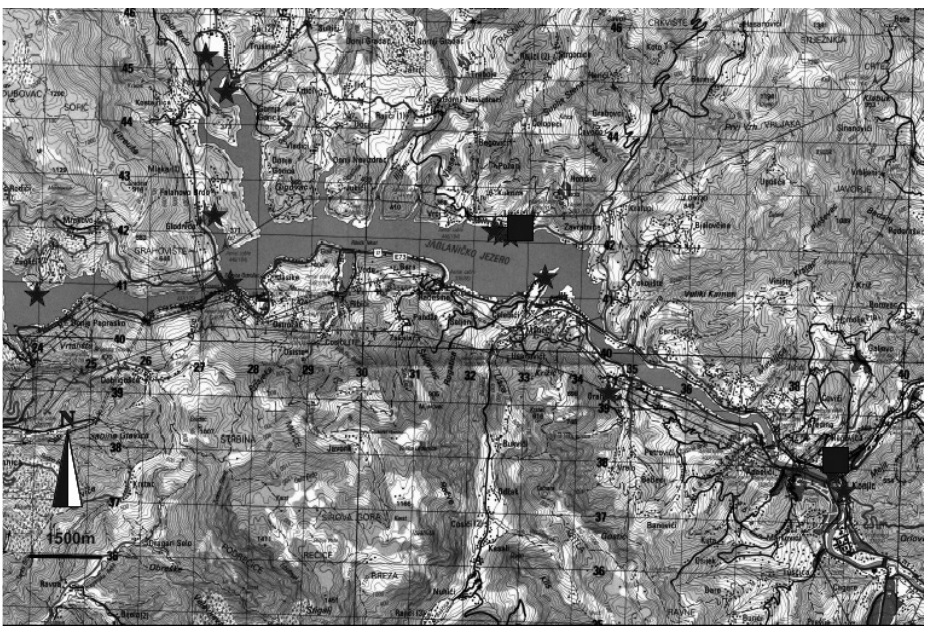
Figure 9: Distribution of villas in the region of Jablaničko Lake, villas marked by stars, Mithraeums by